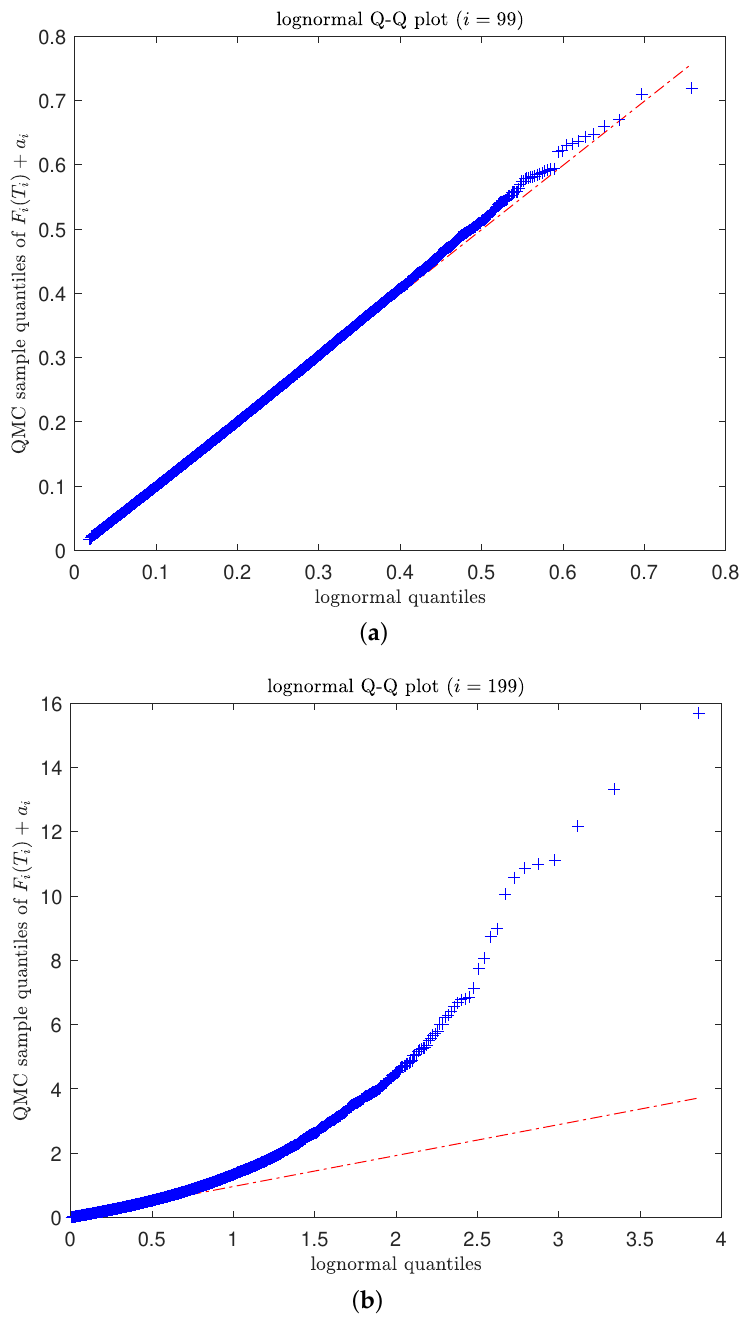
Figure 4. Assessing the lognormal assumption on the distribution of forward LIBORs at two maturi- ties (25 and 50 years) under the five-factor DLFM scenario using Q–Q plots. ( a ) A lognormal Q–Q plot for the realised QMC sample of the forward LIBOR maturing at 25 years. ( b ) A lognormal Q–Q plot for the realised QMC sample of the forward LIBOR maturing at 50